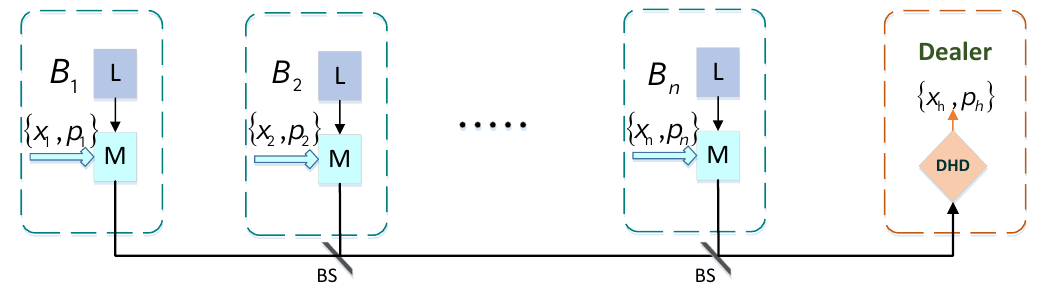
Figure 1. The state preparation of participants and the dealer. L is laser, M represents modulator, BS is beam splitter, DHD expresses double homodyne detector, and { x j , p j } are independent Gaussian random numbers retained by the j th participant B j with j ∈ { 1,2, · · · , n }